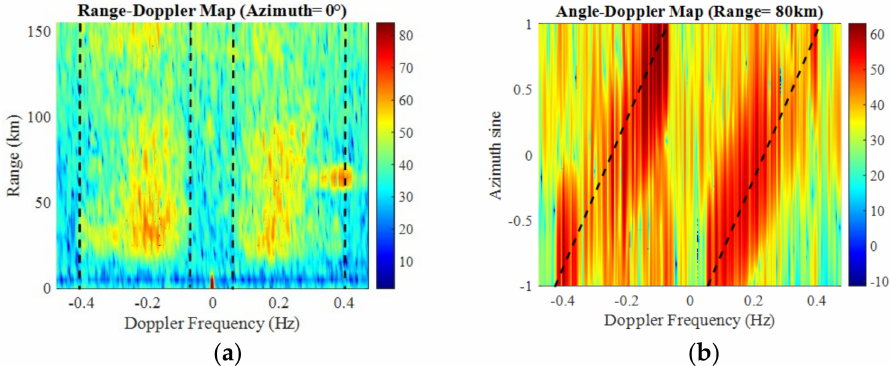
Figure 3. Range-Doppler map and angle-Doppler map of measured data. ( a ) Range-Doppler map, the dashed line represents the spreading region of the first-order sea clutter; ( b ) Angle-Doppler map, the dashed line denotes the clutter